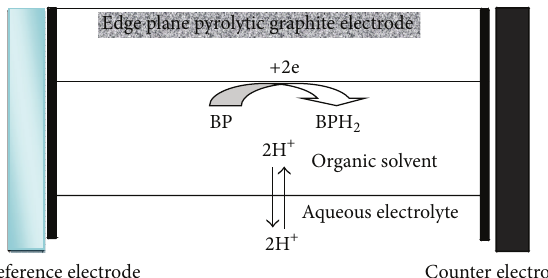
Figure 2: Plane edge pyrolytic graphite electrode covered with a micro film of electroinactive water immiscible organic solvent, con- taining a neutral redox probe and an organic electrolyte, immersed in an aqueous phase-buffered solution containing a common ion with the organic electrolyte. The modified electrode is used in a conventional three-electrode